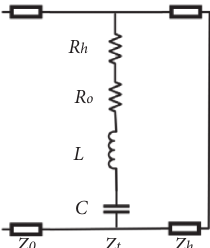
Figure 12: Equivalent circuit model.